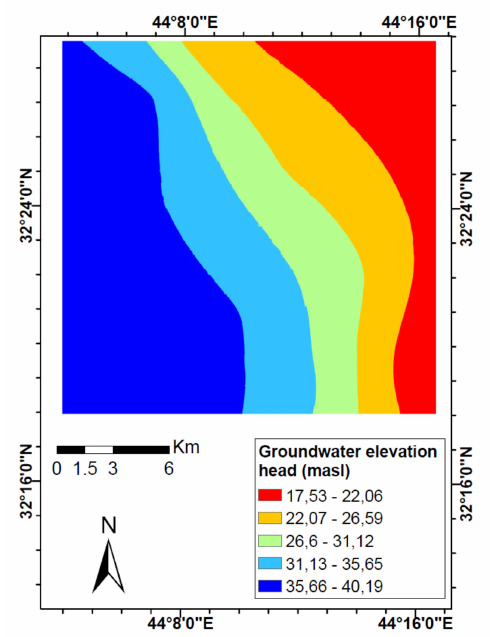
Figure 14. Groundwater elevation map within the Dibdibba region, modified after